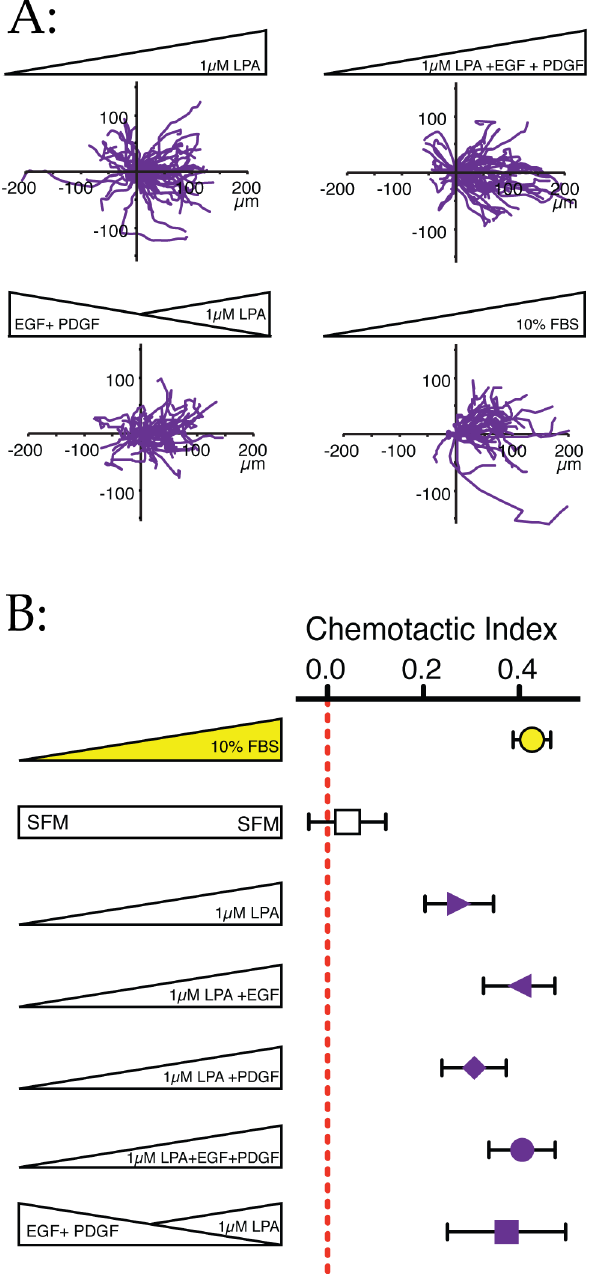
Figure 7. Growth factors potentiate LPA chemotaxis. (A) Growth factors enhance cells’ response to LPA gradients. Figure shows plots of the WM239A paths chemotaxing in gradients of LPA, LPA + EGF + PDGF, and conflicting gradients of LPA versus EGF + PDGF. (B) Chemotactic indices of cells in (A) and other conditions. Growth factor gradients if anything increase the efficiency of LPA chemotaxis, even when applied in a gradient in the opposite direction. Bars show SEM.